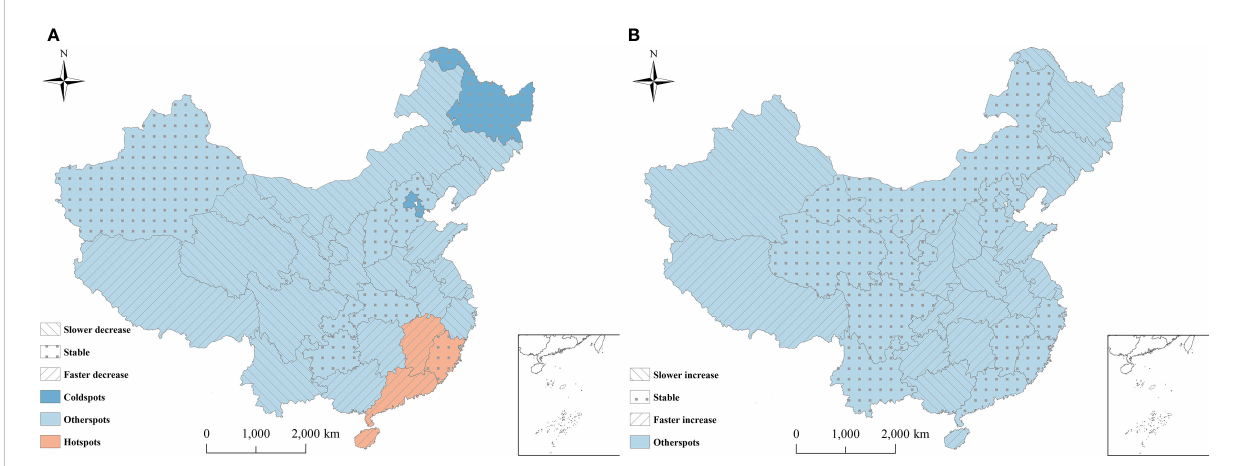
FIGURE 5 Distribution of hot and cold spots of hepatitis B and hepatitis C in China. (A) Hepatitis B; (B) Hepatitis C. The provinces were classi fi ed into nine categories (3 risk categories × 3 trend categories). 3 risk categories: hotspots: P ( exp ( s i )>1| data ) ∈ [0.8, 1] , representing high-risk area; coldspots: P ( exp ( s i )>1| data ) ∈ [0,0.2] , representing low-risk area; neither hotspots nor coldspots: P ( exp ( s i )>1| data ) ∈ (0.2,0.8) . 3 trend categories: level 1, the variation trend of the disease is faster than the overall trend, if P ( b 1 i >0| h i , data ) ∈ [0.8,1] ; level 2, the variation trend of the disease is slower than the overall trend, if P ( b 1 i >0| h i , data ) ∈ [0,0.2] ; level 3, the variation trend in the disease has no difference with the mean level, if P ( b 1 i >0| h i , data ) ∈